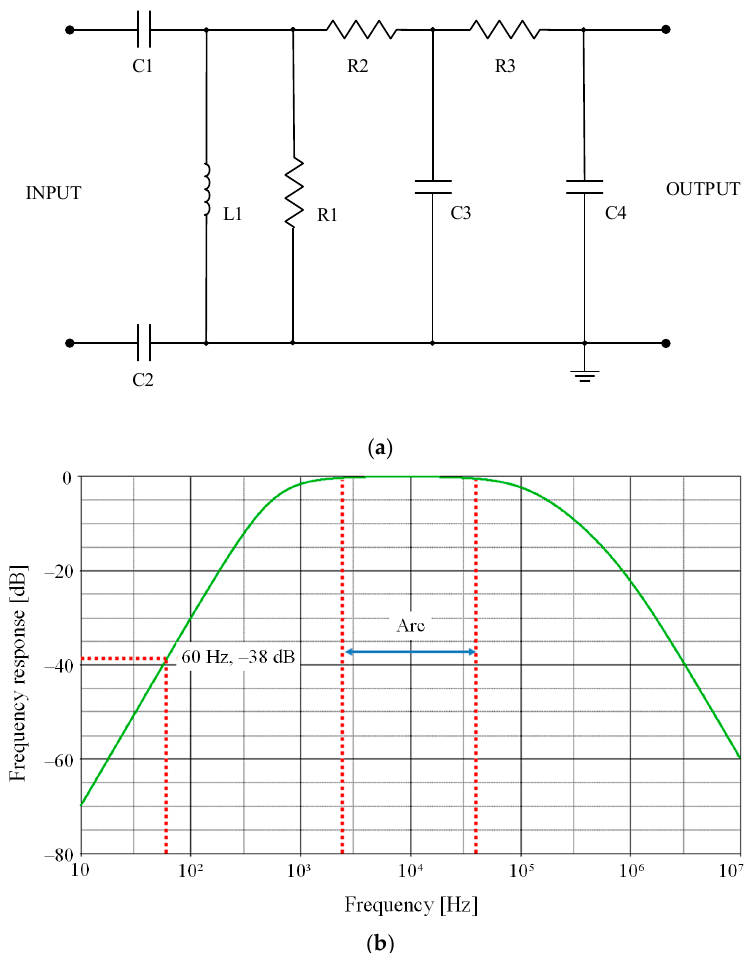
Figure 5. Arc detection filter. ( a ) Circuit diagram; ( b ) frequency response.